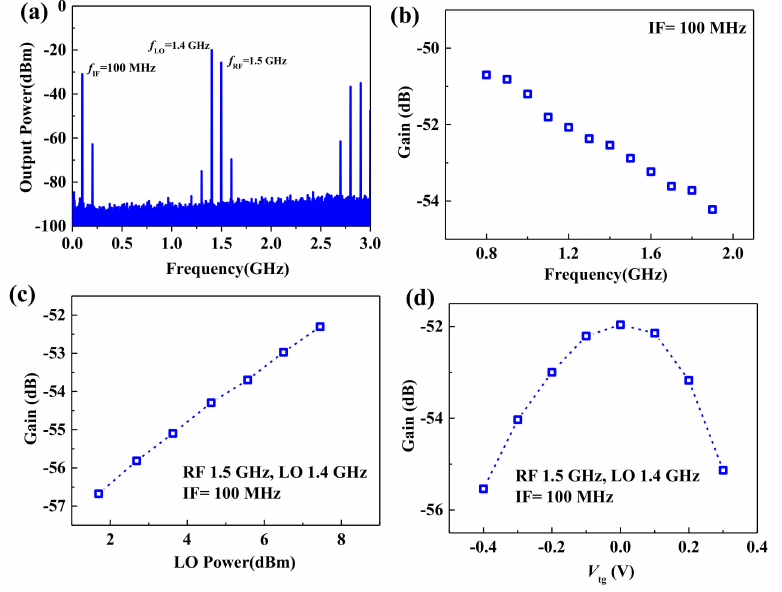
Figure 7. Gigahertz flexible MoS 2 mixer. ( a ) Output frequency spectrum of the flexible MoS 2 mixer. ( b ) Conversion gain of MoS 2 mixer versus input frequency. ( c ) Conversion gain of MoS 2 mixer versus local oscillation (LO) power. ( d ) Conversion gain of MoS 2 mixer versus gate